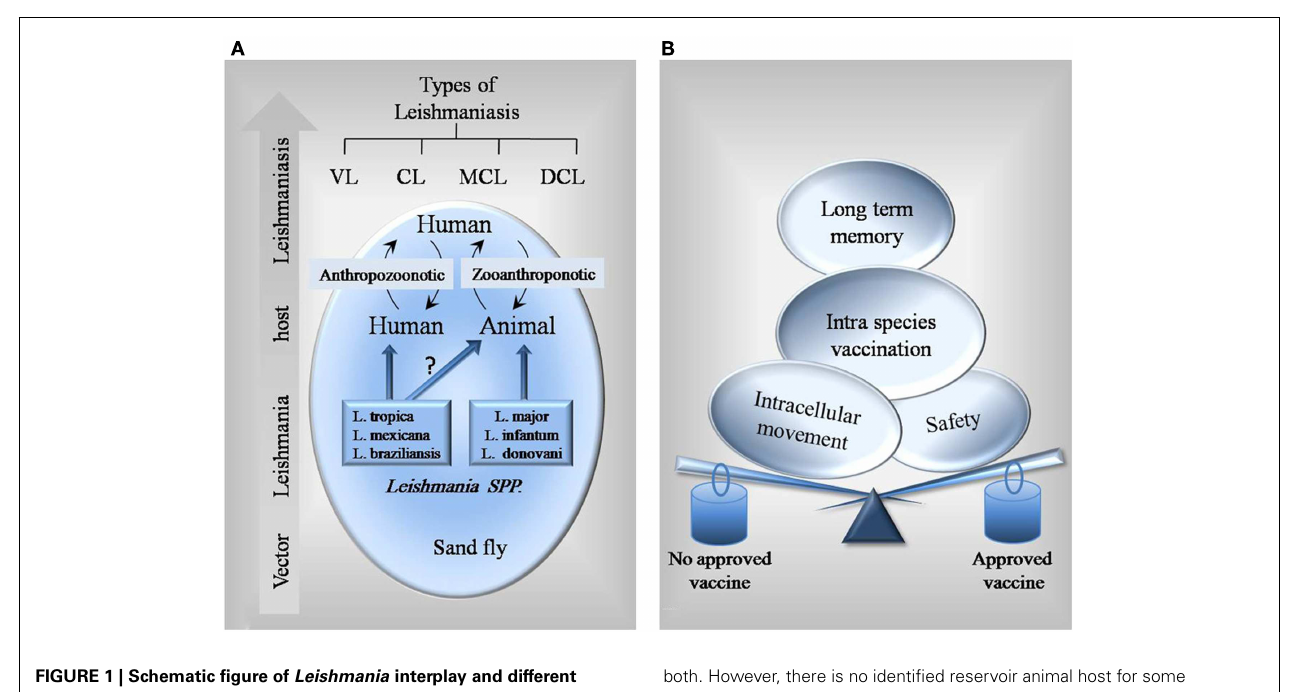
FIGURE 1 | Schematic figure of Leishmania interplay and different factors to consider in vaccine design. (A) Most of Leishmania parasites such as L. infantum and L. donovani are known to have both human and animal hosts, so preventive vaccines could be designed for